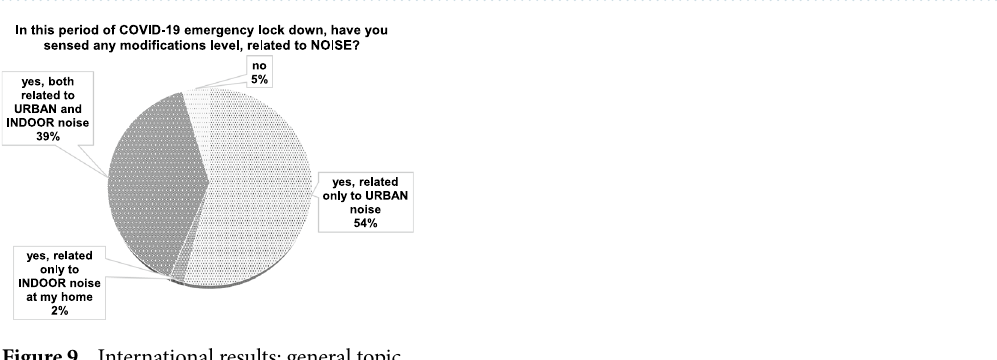
Figure 9. International results: general